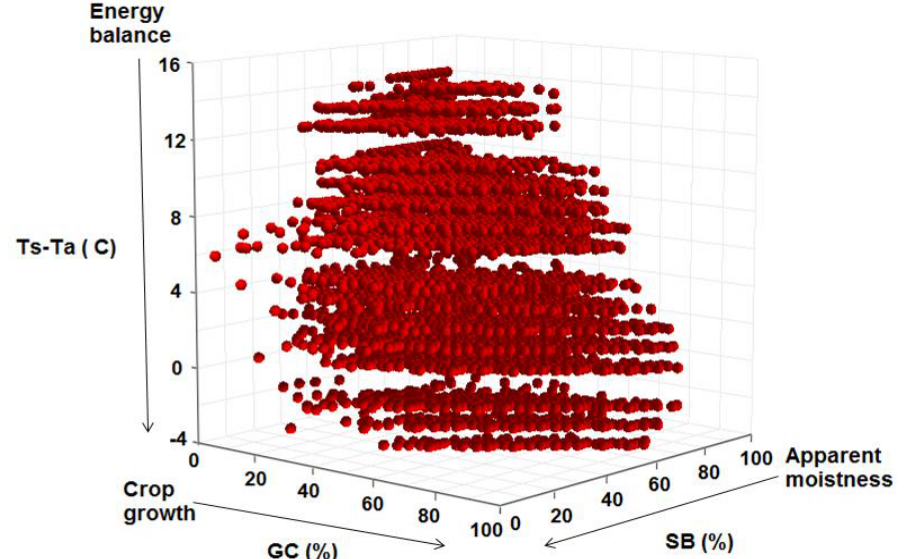
Figure 9. GC, SB and Ts-Ta plotted on three orthogonal axes. GC is associated with crop growth, SB with apparent soil moistness and Ts-Ta with the surface energy balance. Plotted data are for the 8 August 2007, image acquisition